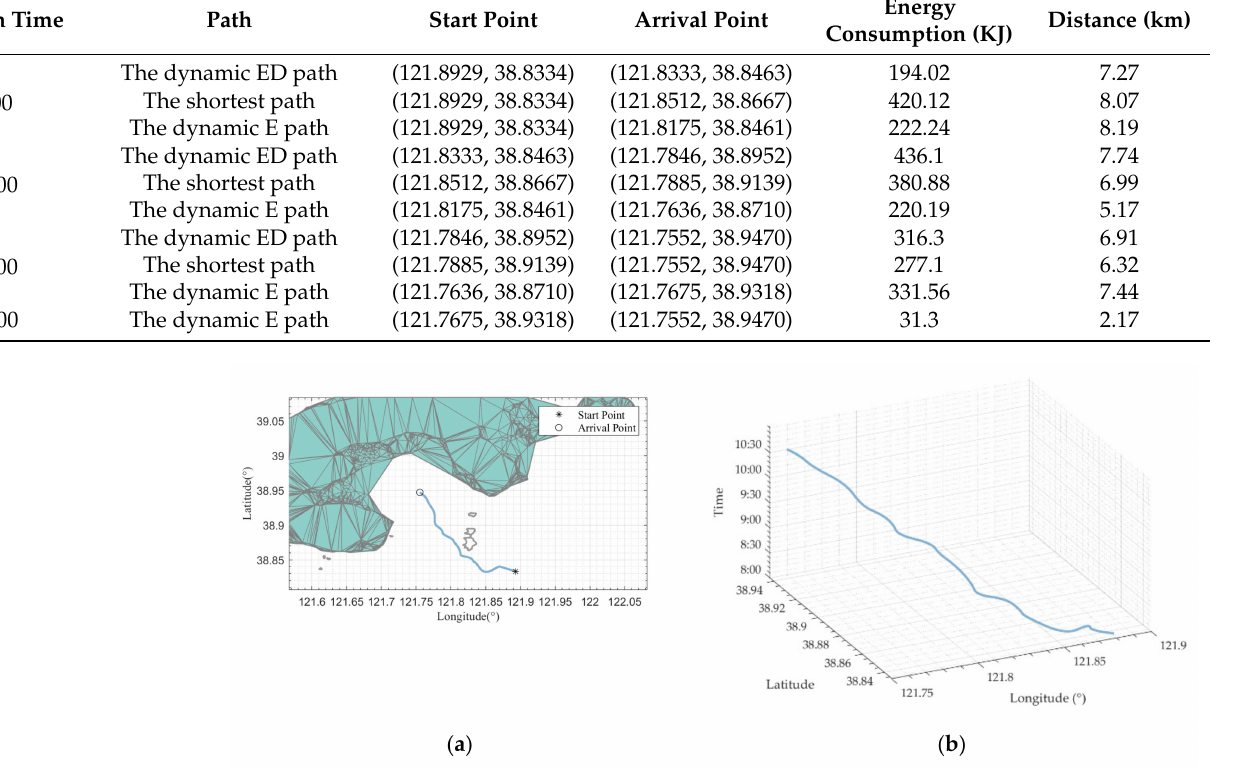
Figure 16. Where ( a ) represents the hourly dynamic energy-efficient path and considers the distance after optimization. ( b ) Simulation results of positions of USV concerning time.